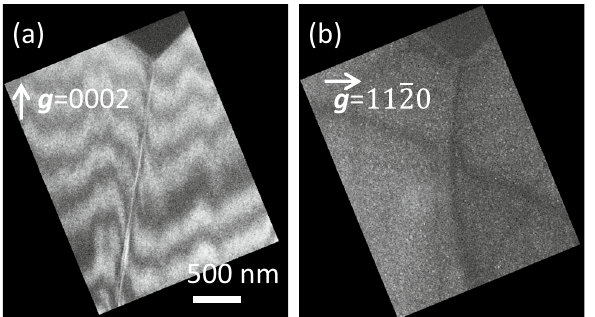
Figure 3. Cross-sectional weak-beam dark-field TEM images of TDs under the leaky M-pit (i.e., #M2) acquired with ( a ) g = 0002 and with ( b ) g = 11 2 0.